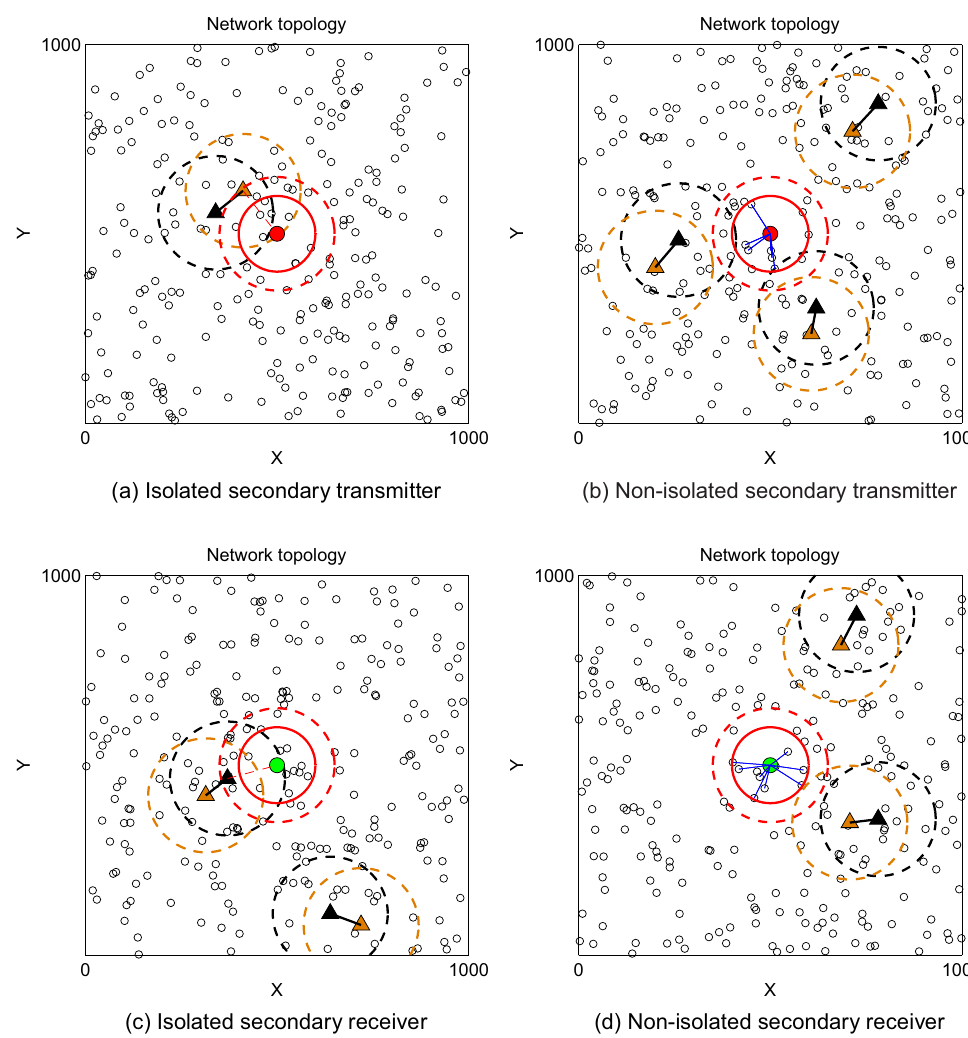
Figure 5. Illustration of isolation possibility of secondary transmitter and receiver. a = 1000 m, N S = 250, N P = 5, λ P = 0.5, R T = r T = 100 m, R I = r I = 150